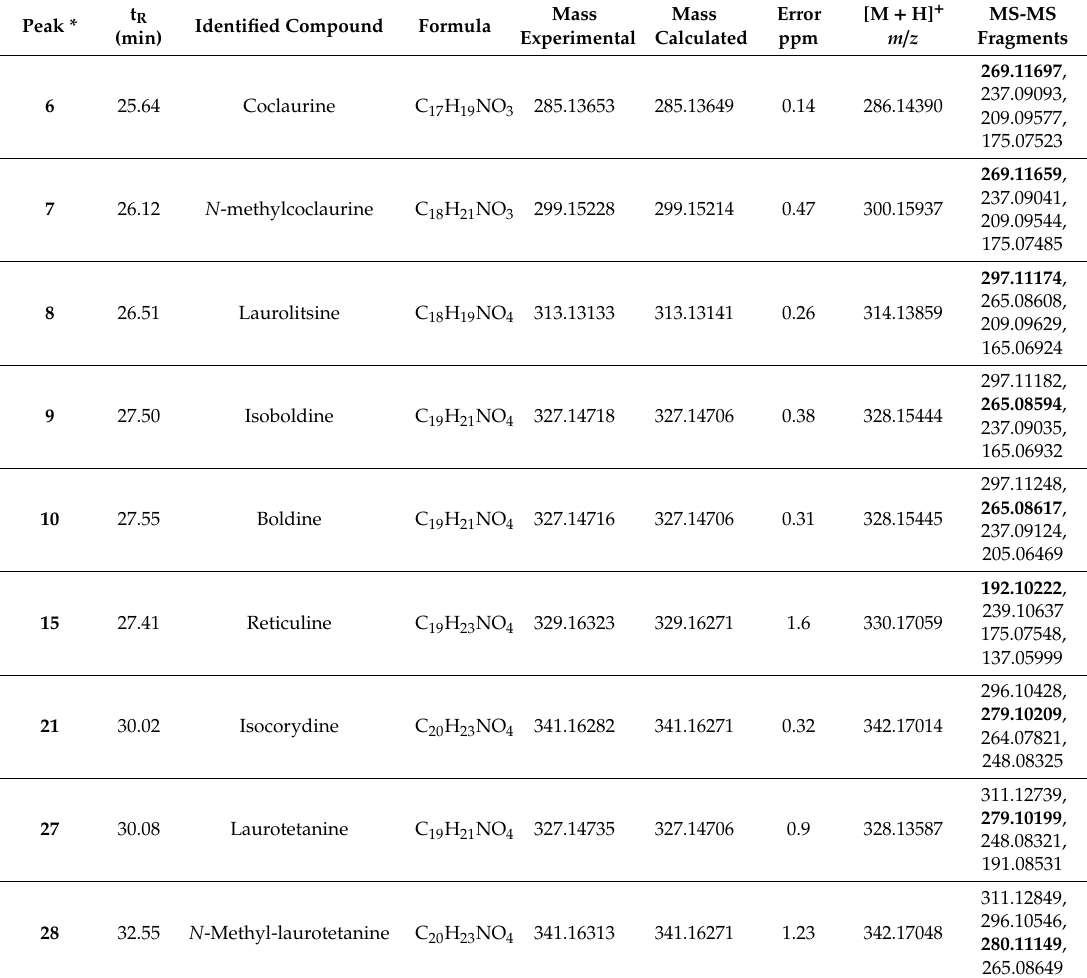
Table 2. Alkaloids identified from P. boldus with the high-performance liquid chromatography coupled with quadrupole time-of-flight high resolution mass spectrometry (HPLC QTOF-MS / MS) method in positive ionization